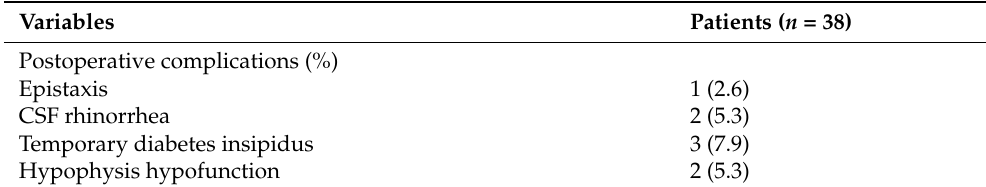
Table 7. Postoperative complications of 38 patients with cystic pituitary prolactin- secreting